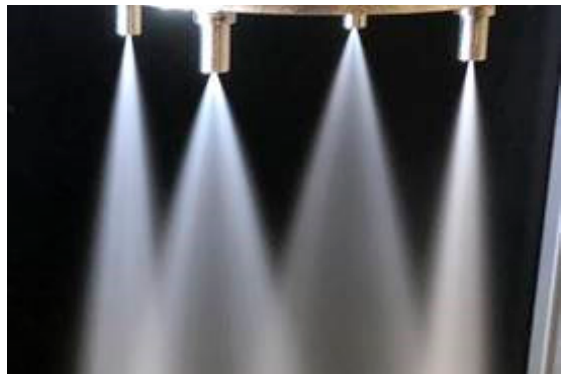
Figure 11. Photo of base load fuel flow for four main nozzles operated in parallel in one combustor. Water is used as medium in quiescent air.